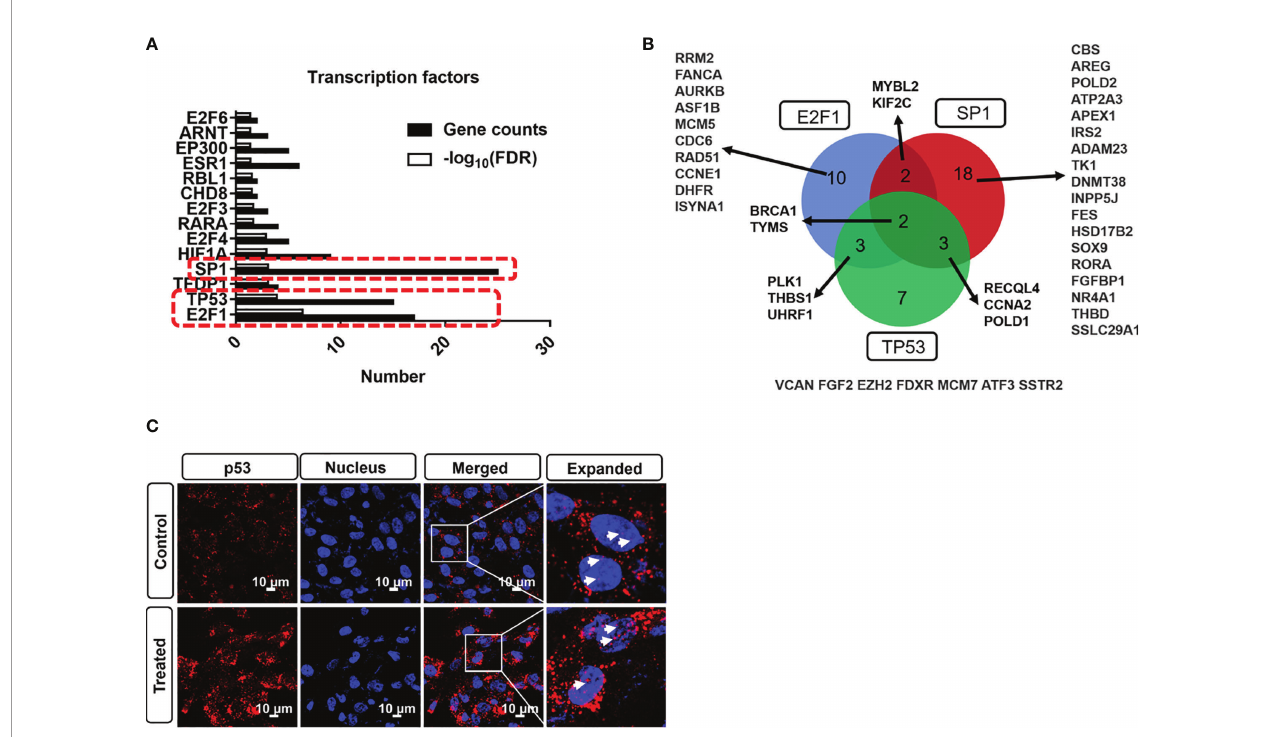
FIGURE 4 | (A) Transcription factor pro fi le of DEGs with photodynamic intervention (dose 20 J/cm 2 ) using TRRUST database. (B) DEGs overlap among E2F1, SP1, and TP53 transcription factors. (C) Immunostaining of p53 nuclear translation after photodynamic intervention (20 J/cm 2 ). Scale bar is 10 m